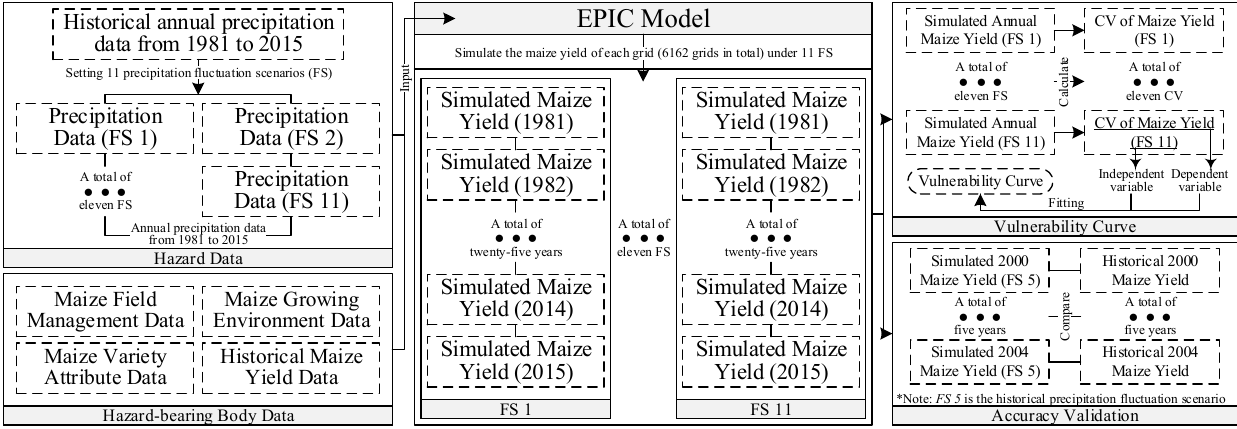
Figure 1. Research framework for the study.